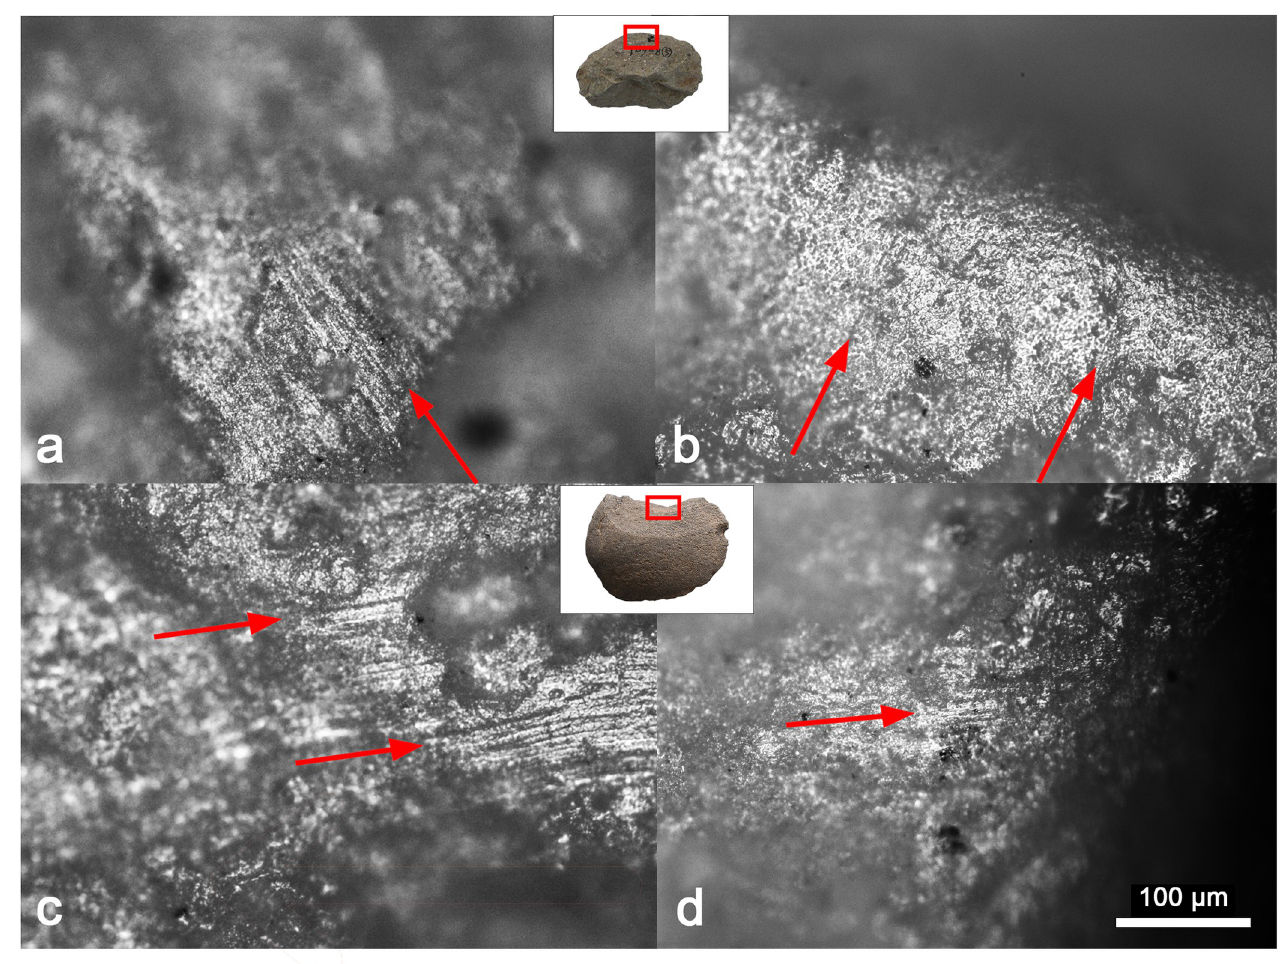
Fig 8. Use-wear traces from rice harvesting flakes. (a) and (b) Use-wear traces from Artifact SS-10 exhibit fine striations perpendicular or diagonal to the cutting edge, suggesting a transverse motion. (c) and (d) Use-wear traces from Artifact HHS-38 are dominated by striations parallel to the cutting edge, suggesting a slicing